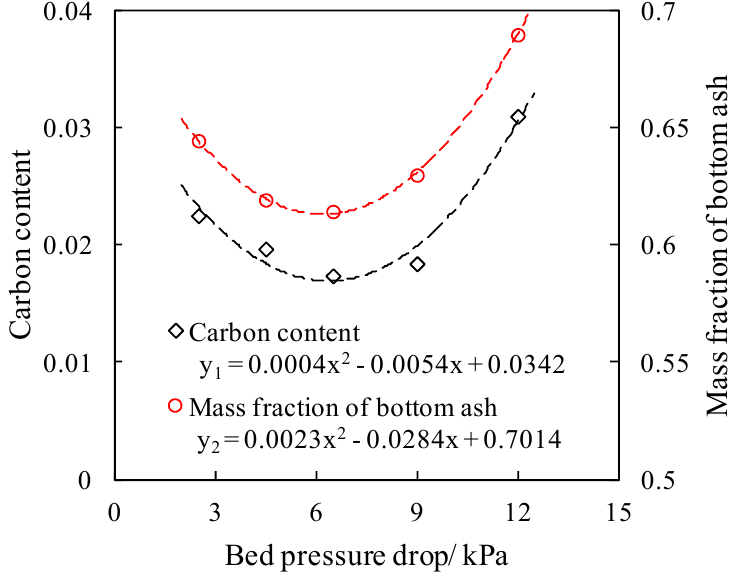
Figure 12. Carbon contents in fly ash and bottom ash under different bed pressure drop.